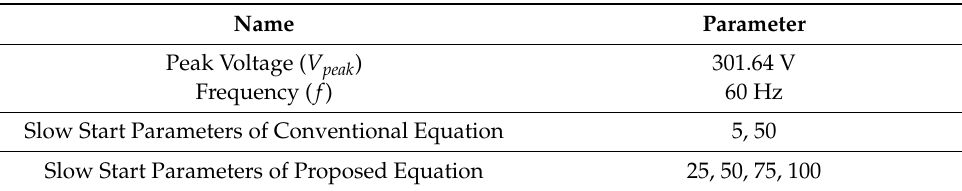
Table 4. Parameters of external excitation.